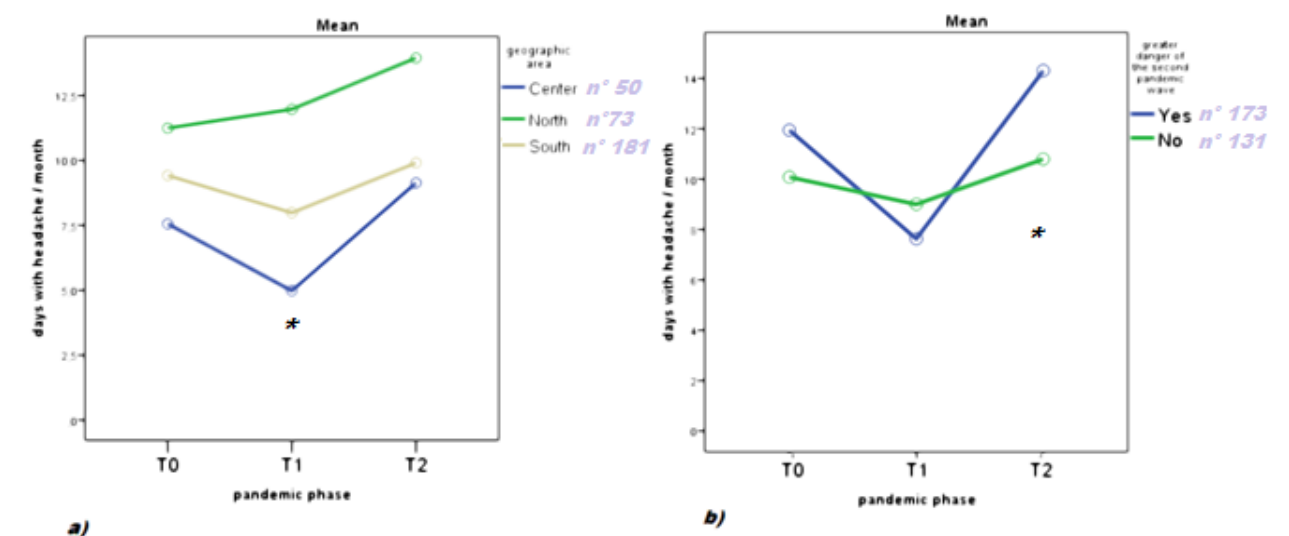
Figure 1. Headache frequency before pandemic (T0), during first pandemic phase (T1), and during second pandemic phase (T2). Results of repeated measures ANOVA with: ( a ) geographic areas as factor. F: 2.50 p 0.03; degree of freedom 4; degree of error 602; * T0 vs. T1 p < 0.05; ( b ) subjective judgment of the second wave more dangerous than the first as factor F 3.16 p 0.044. Degree of freedom 2; degree of error: 301 sample size; Yes: 173; No: 131. * T0 vs. T2 p < 0.05.